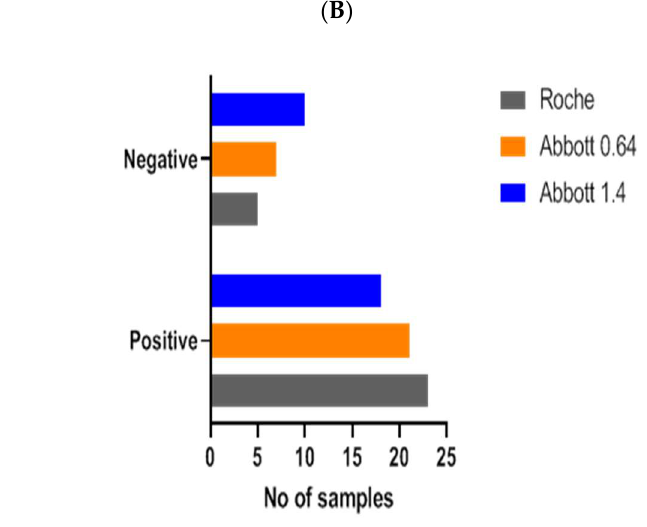
Figure 5. SARS-CoV-2 antibody outcomes (positive, negative) were compared with our redefined Abbott threshold (Abbott 0.64) and the manufacturer’s threshold (Abbott 1.4) in samples analysed at PHU ( A ) and DGH ( B ). Serological outcomes derived from redefined and manufacturer’s Abbott threshold were also compared with outcomes reported by TBS ( A ) and Roche ( B ). In comparison to the Abbott manufacturer’s threshold, the use of Abbott 0.64 demonstrated no significant differences and improved concordance and agreement between serological outcomes produced by TBS and Roche.